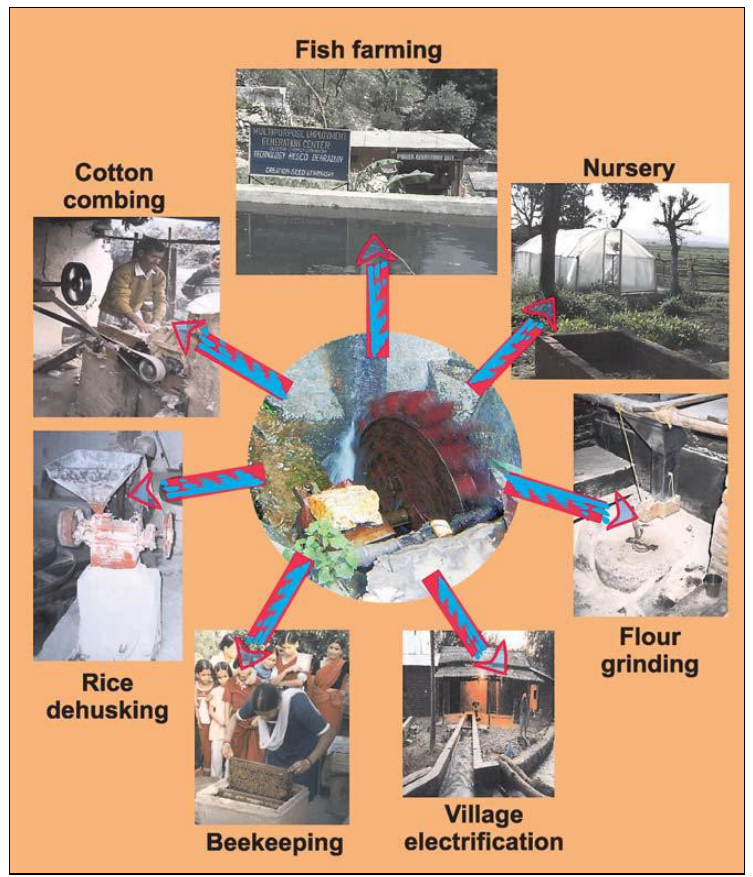
Figure 25. The integrated water mill model in small farms shows how a stream can become a mul- tifunctional source of power and community development (adapted from [58]). Optimization of water mills’ benefits is not only important for sustainable/regenera- tive development but is also cost-efficient, particularly for small farms. Quaranta et al. [59] showed this optimization, based on improving water wheels and installation of Turgo turbines, will generate an income of UAD 20,000 and USD 83,000, respectively, in 20 years (Table 1). The force of the water was and can be used to produce mechanical power for centu- ries. There are many lessons that we can learn by studying water mills. Historical